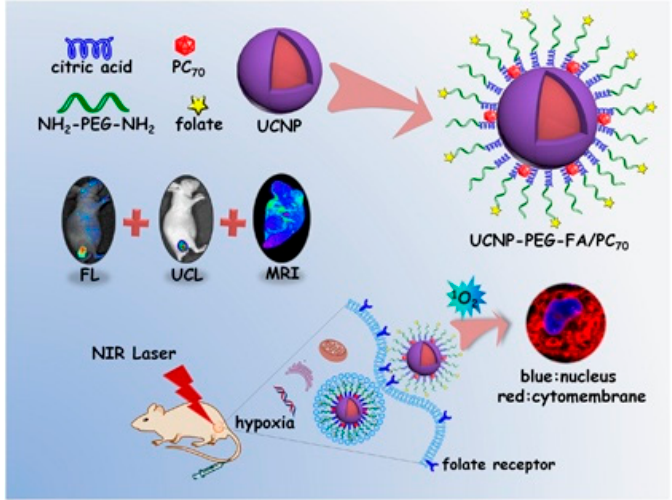
Figure 2. Schematic illustration of trimodal imaging guided UCNP–PEG–FA/PC 70 (upconversion– nanoparticles–trismethylpyridylporphyrin–fullerene nanocomposite) strategies for PDT. Adapted with permission from [71].